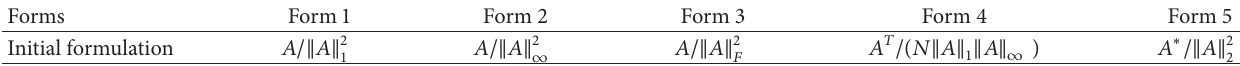
Table 1: Some of the general ways to choose 𝑉 0